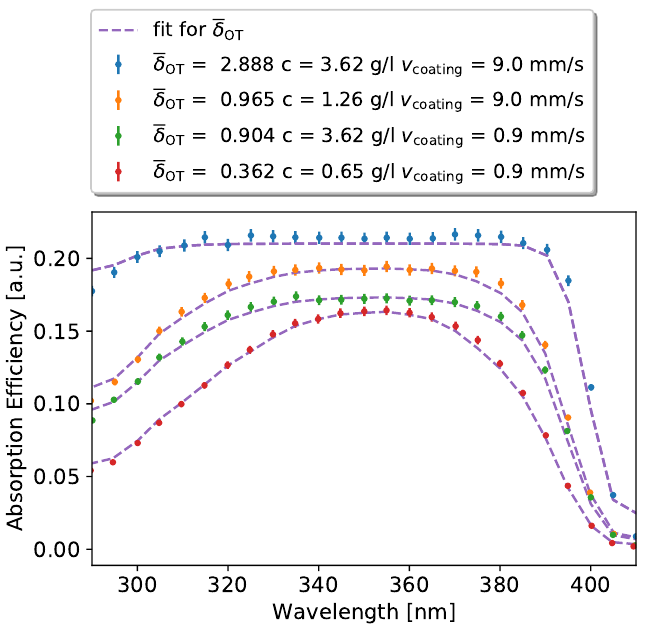
Figure 8. Absorption efficiency for different coating velocities v coating and concentrations c of Bis-MSB in a WLS paint mixture of 400mL of anisole and 85.1g of PEMA (the second WLS was not used here). The methodology of the experiment is described in Ref. [24]. Shown in purple are fits to the different absorption efficiencies using Equation (7) multiplied by a normalization constant.